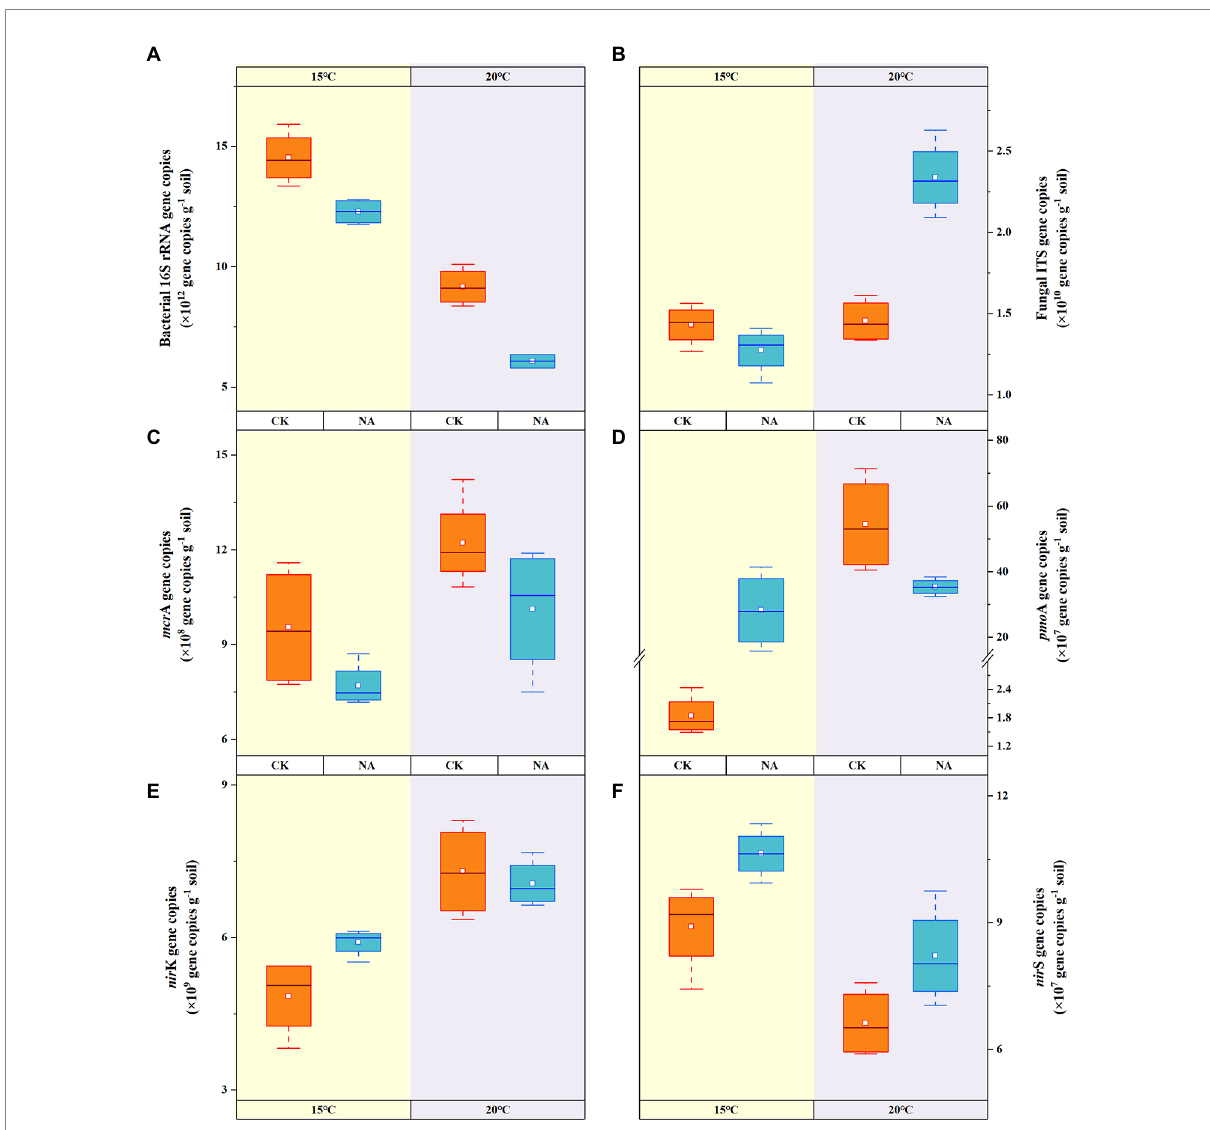
FIGURE 3 Effects of temperature rising and nitrogen addition on soil bacterial (A) , fungal (B) , mcr A (C) , pmo A (D) , nir K (E) , and nir S (F) abundances in permafrost peatland. CK, control; NA, add 50 mg N kg − 1